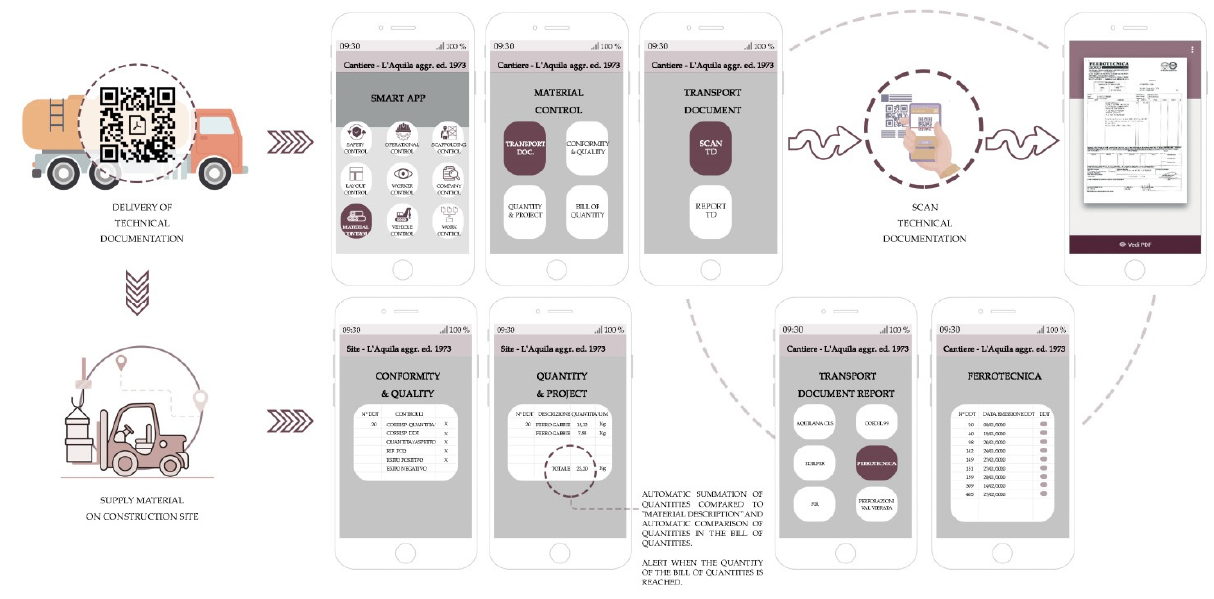
Figure 8. Materials control—SmartApp.